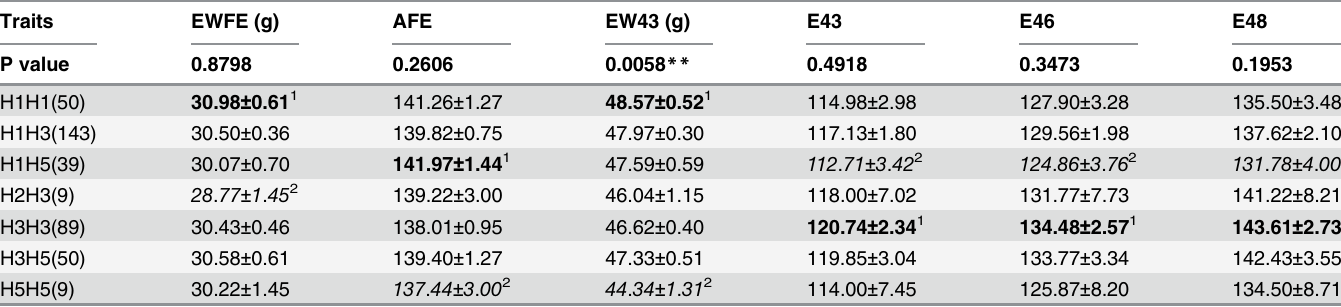
Table 6. Association of diplotypes of chicken BMP15 gene with the reproductive traits.